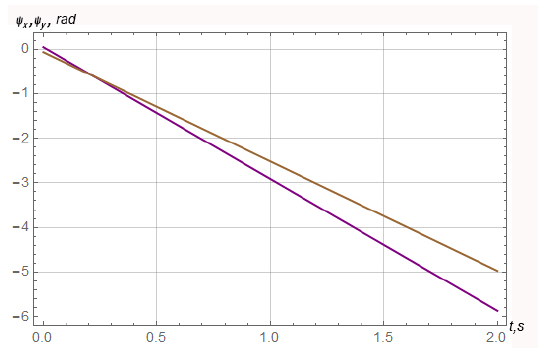
Figure 24. Changes of generalized angular coordinates: ψ х – purple, ψ y – brown